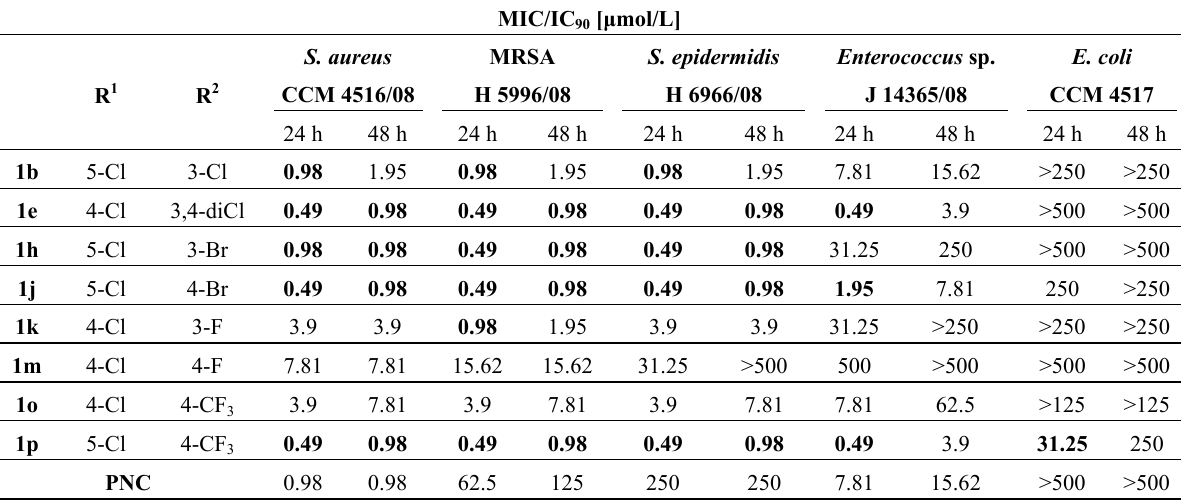
Table 4. MICs of salicylanilide 4-(trifluoromethyl)benzoates 1 towards selected